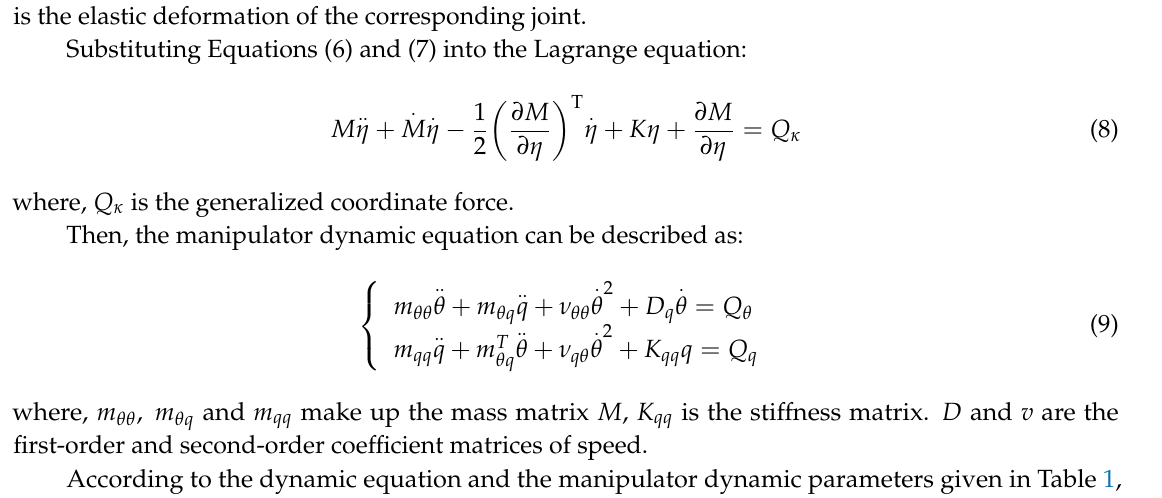
Table 1. Parameters of heavy-duty manipulator.